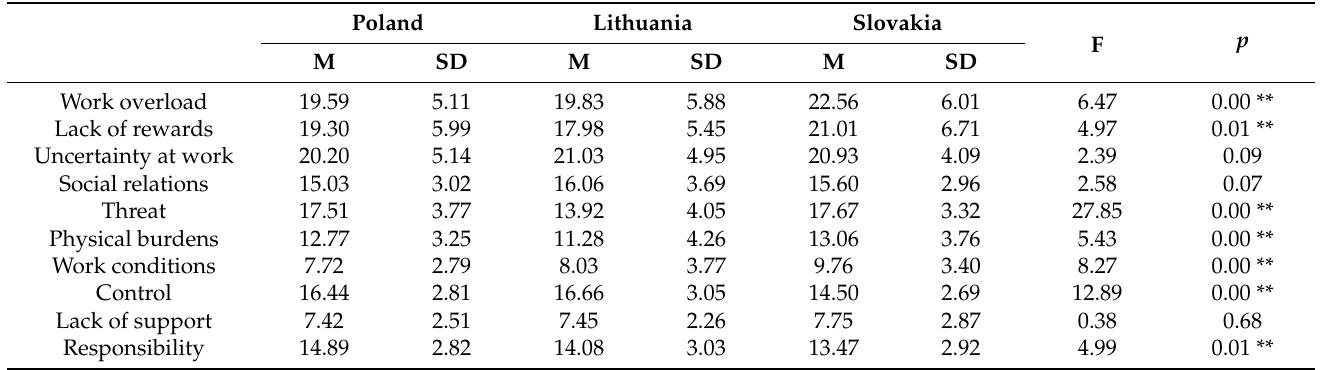
Table 1. Differences among professional drivers from Lithuania, Slovakia, and Poland in perception of workplace environmental factors.